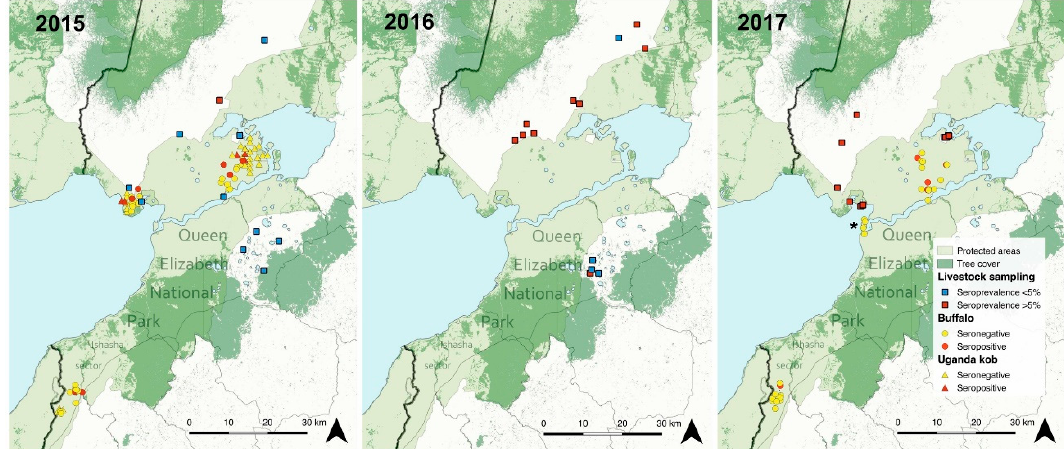
Figure 2. Sampling locations and results of PPRV antibody detection in livestock and wildlife from Queen Elizabeth National Park (QENP), western Uganda from 2015–2017. Livestock sampling locations with seropositive animals are shown. District borders are shown in grey and the national border with DRC is shown with a thicker black line. The asterisk indicates Mweya Peninsula in the right image in 2017. The Kazinga channel connects Lake Edward (left) with Lake George (right) and divides QENP. The tree cover within QENP indicates the location of Maramagambo Forest.